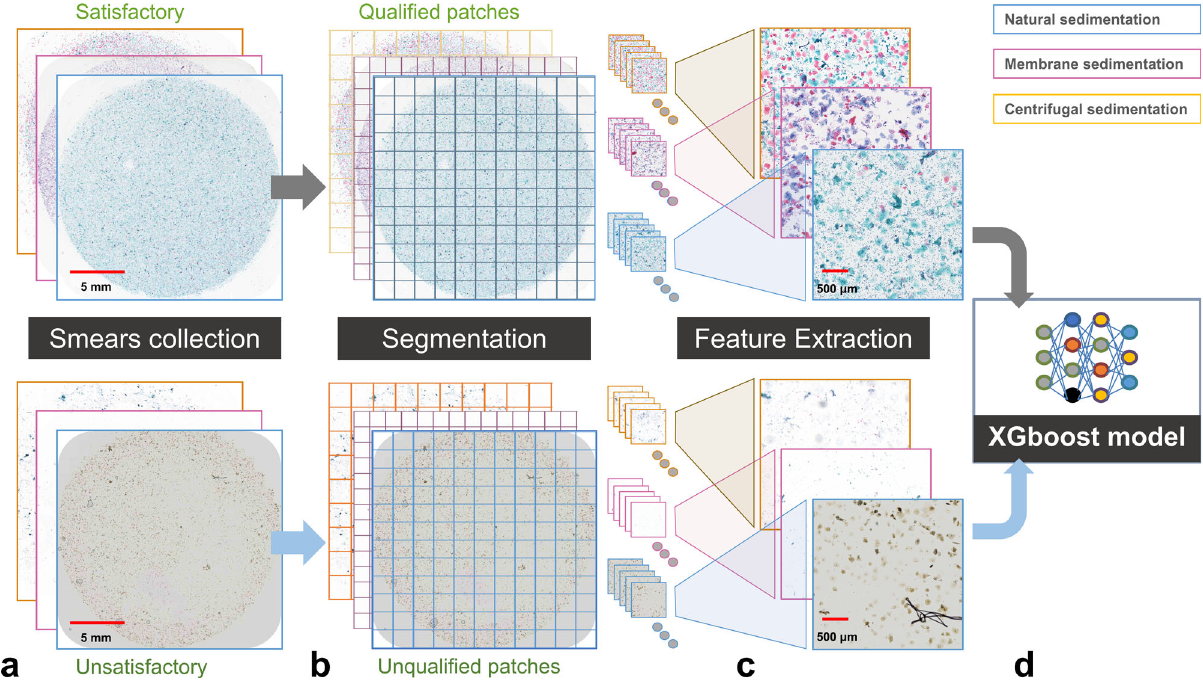
Fig. 5 Development of the ef fi cient AI-based Digital Pathology Image Quality Control (DPIQC) system. a Screening satisfactory and unsatisfactory digital smears produced by three different sedimentation methods. b Division of the whole digital smears into patches with a size of 6000 × 6000 pixels. c Feature extraction of the patches. d Trained XGBoost model for predicting whether digital smear was quali fi ed. The representative images in ( a – c ) display the construction process of the DPIQC system.